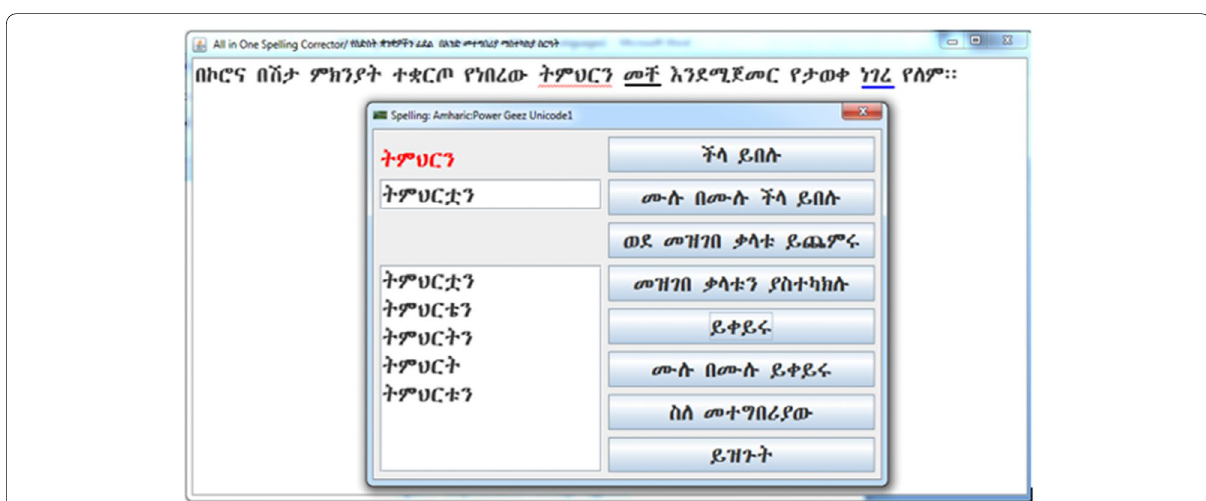
Fig. 7 Sample GUI for word